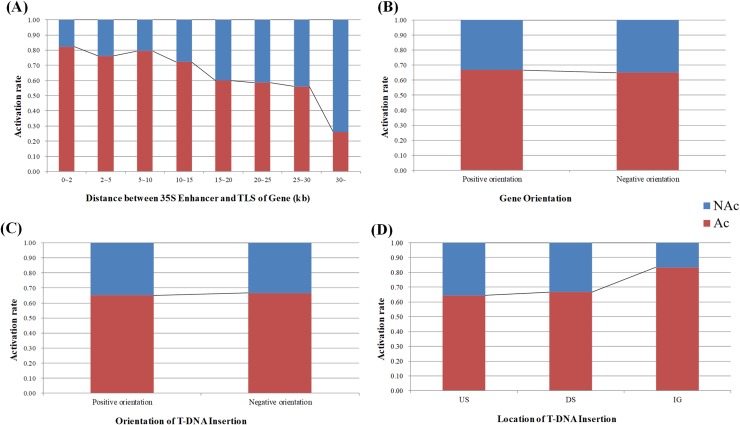
Correlation analysis of enhancer property and the activation ratio of genes.In the interaction between the enhancer and the target gene, we have summarized four properties including. (A) The distance from the 35S enhancer of the T-DNA insertion site to the TLS of gene. (B) Gene orientation. (C) Orientation of T-DNA insertion (enhancer's orientation). (D) Location of T-DNA insertion (enhancer’s location). US (Up-stream): T-DNA inserts into upstream of target gene, DS (Down-stream): T-DNA inserts into downstream of target gene, IG (Intragenic): T-DNA inserts into intragenic of target gene.